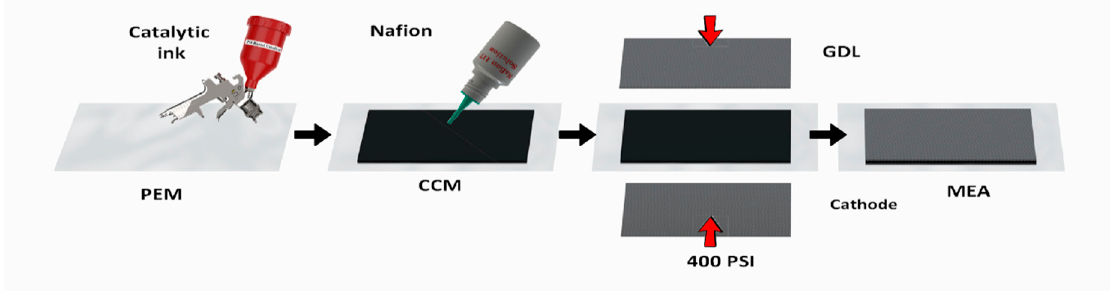
Figure 1. Schematic illustration of membrane electrode assembly (MEA) fabrication.